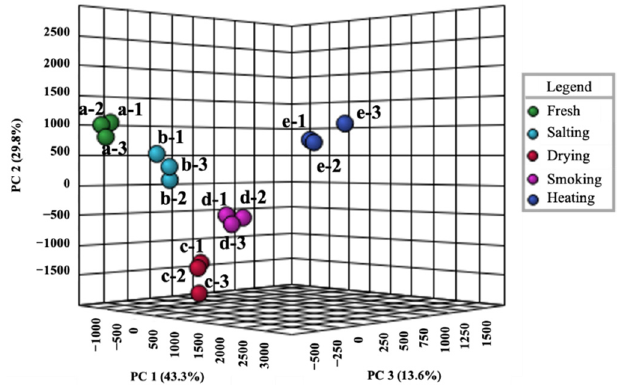
Figure 6. PCA based on the signal intensity of smoke-flavored sea bass with different production steps via HS-GC-IMS. a: fresh fish; b: salting; c: drying; d: smoking; e: heating.